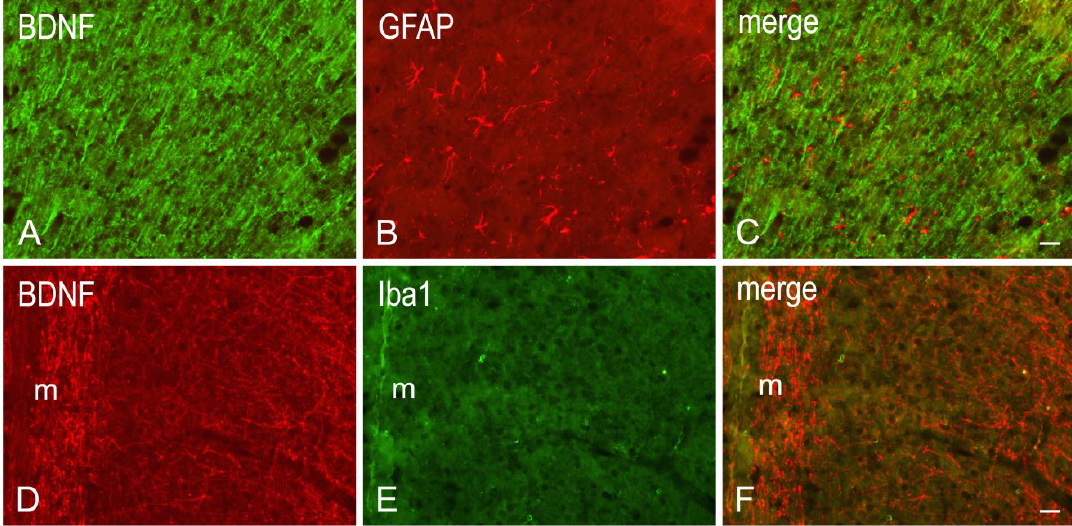
Figure 4. Double immunofluorescence for BDNF ( A , C , D , F ) and either glial fibrillary acidic protein (GFAP) ( B , C ) or Iba1 ( E , F ) in representative coronal sections of frontal cortex of BCCAO / R + RVT rats. m, molecular layer. Scale bars A, B = C: 25 µm; D, E = F: 25 µm.